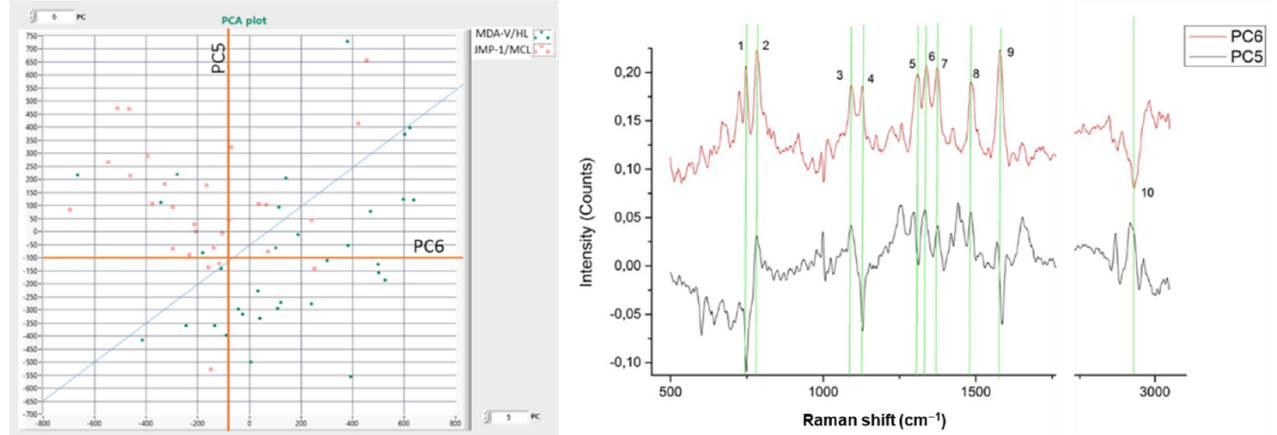
Figure 2. ( left ) Comparison ( n = 60) between MDA-V/HL and JMP-1/MCL NHL cell lines; ( right ) PC Raman spectra showing the cell lines spectral differences.